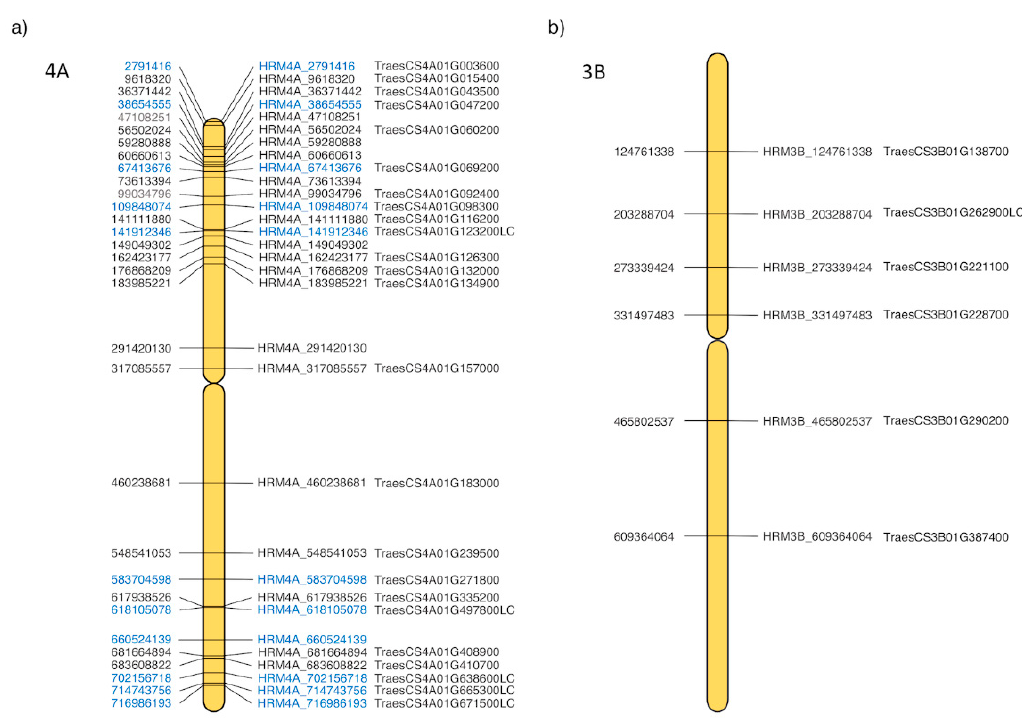
Figure 4. Physical maps for the wheat chromosomes 4A ( a ) and 3B ( b ) showing the molecular markers location and their nearest genes found within a window of +/ − 20 kb and +/ − 300 kb, respectively. ISBP markers used in wheat variability assessment are highlighted in blue.